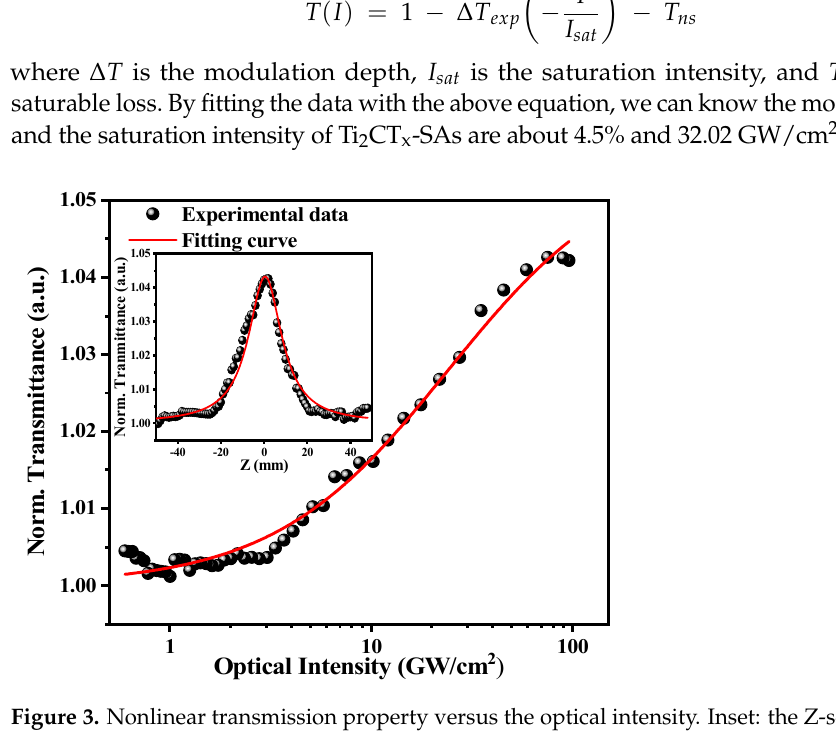
Figure 3. Nonlinear transmission property versus the optical intensity. Inset: the Z-scan curve of the Ti 2 CT x -SAs.